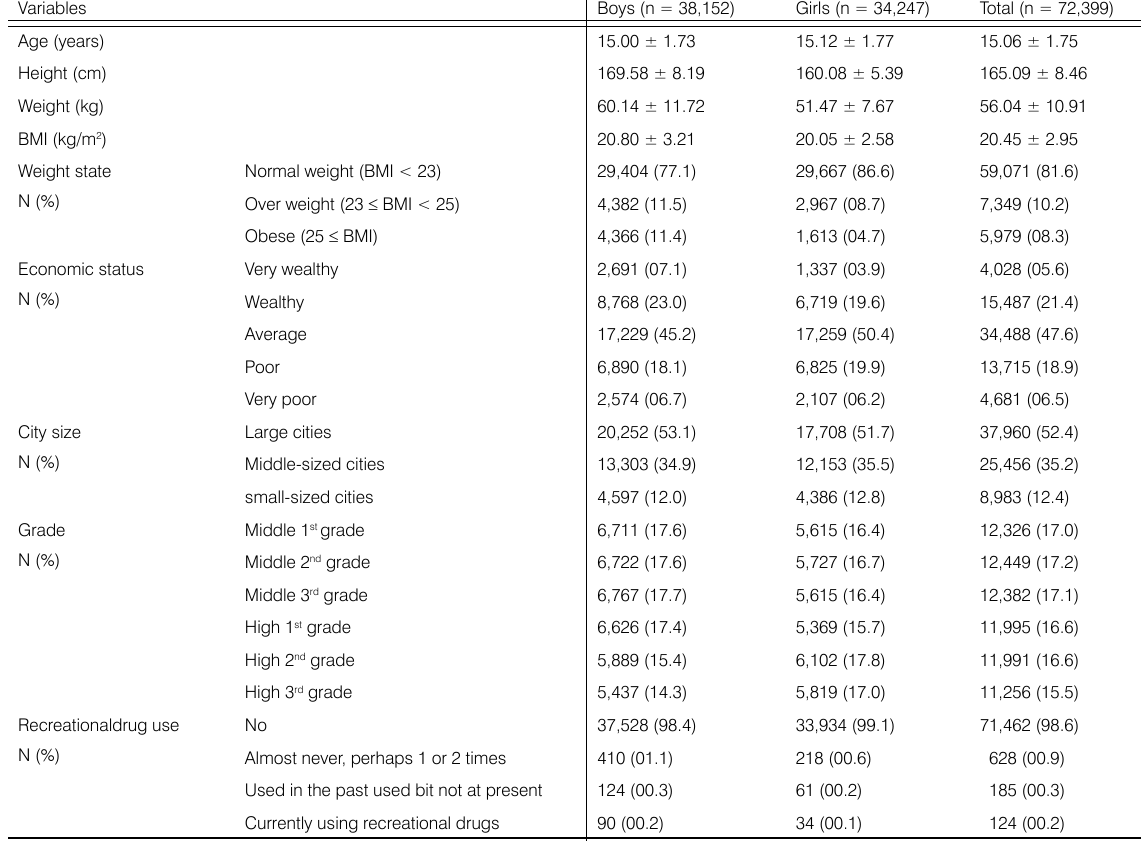
Table 1. Characteristics of subjects (Mean ±